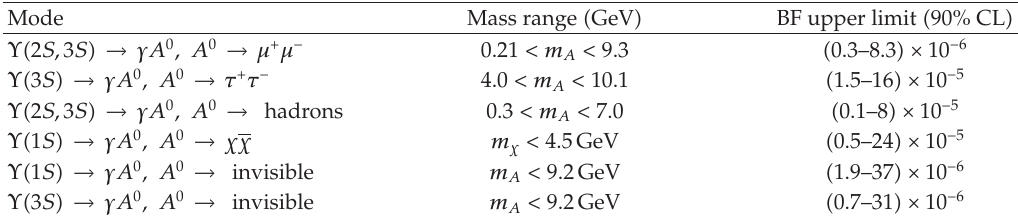
Table 2: Results of light Higgs boson searches performed by the BABAR Collaboration.